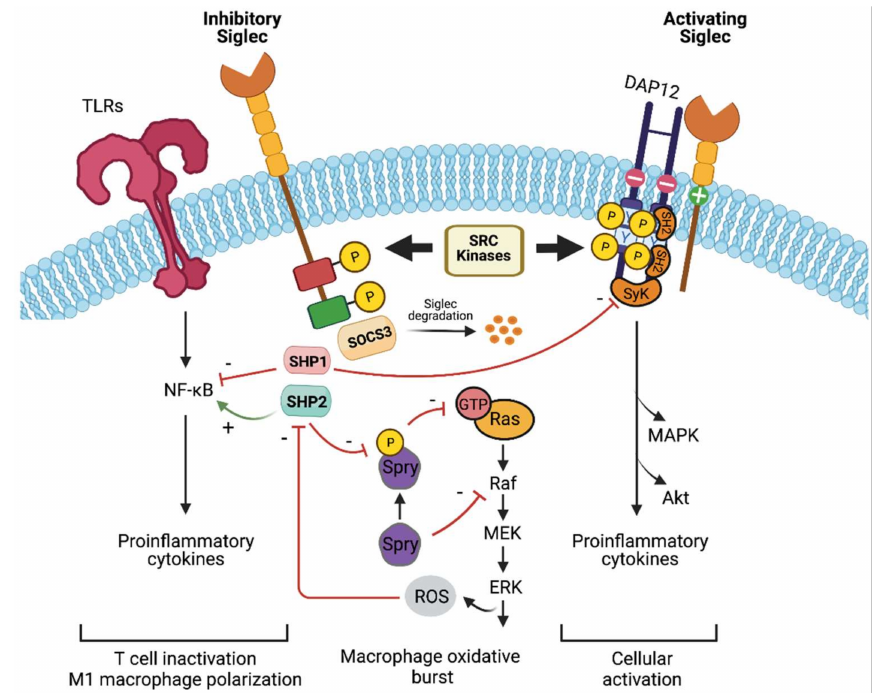
Figure 3. Siglec signaling and immune modulatory effect. Upon sialic acid binding, SRC kinases can phosphorylate tyrosine residues found in the cytosolic ITIM/ ITAMs. Within the inhibitory Siglecs, SHP-2 is recruited to the phosphotyrosines and can inhibit Sprouty (Spry). The inhibition of Spry promotes the activation of Ras-ERK signaling and subsequent ERK and Akt-dependent production of reactive oxygen species (ROS) [182,183]. ROS in sepsis can inactivate SHP-2, resulting in